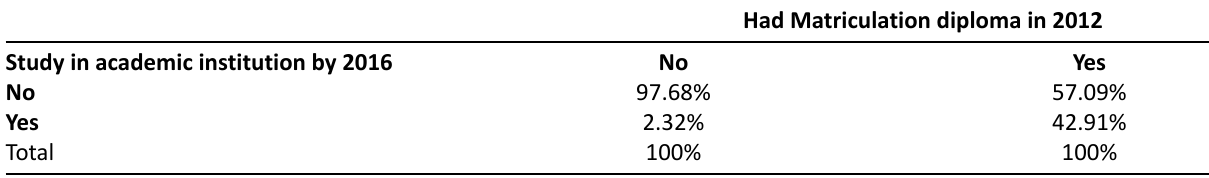
Table 1. Distribution (%) of the studying status by 2016 of respondents who did and did not had Matriculation diploma at 2012.